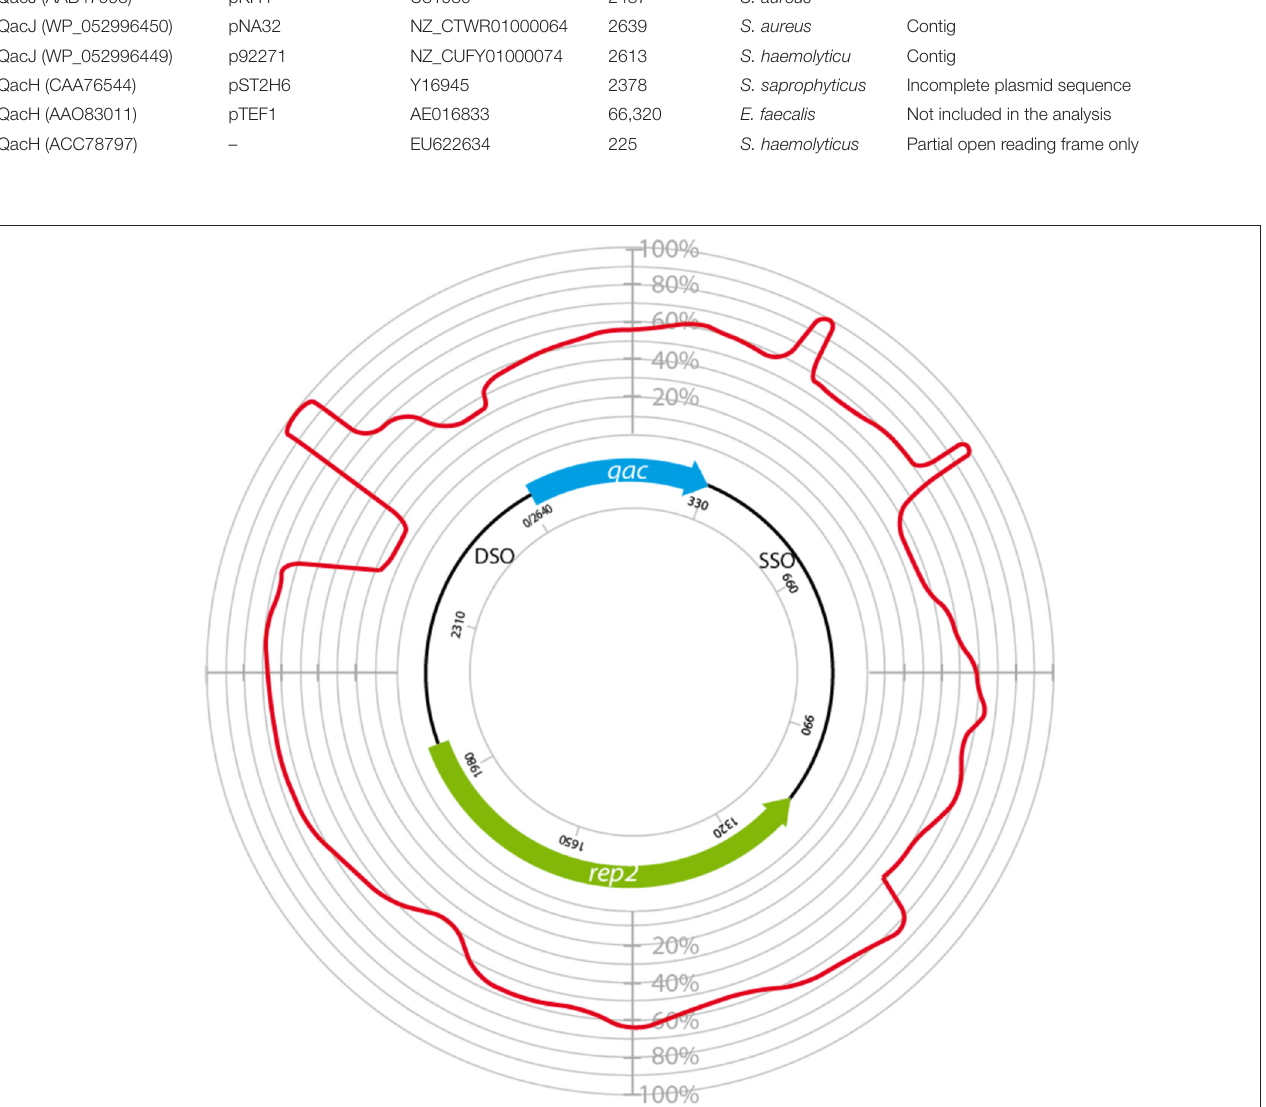
FIGURE 5 | Circular homology plot of plasmids bearing variable qac genes. The homology is based on 4 QacC plasmids (Type II, Table 1 ) and 5 QacG, 5 QacJ, and 1 QacH plasmids, listed in Table 2 .